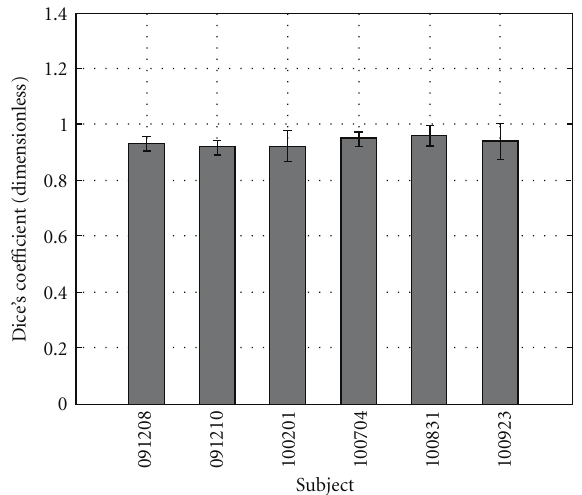
Figure 11: Average and standard deviation of Dice’s coe ffi cient for each data set of four image